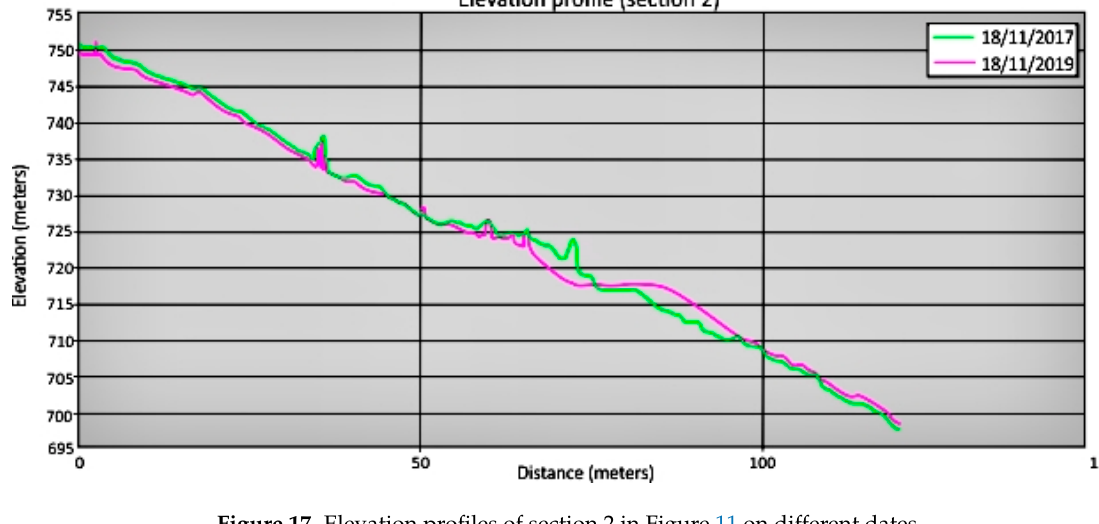
Figure 17. Elevation profiles of section 2 in Figure 11 on different dates.